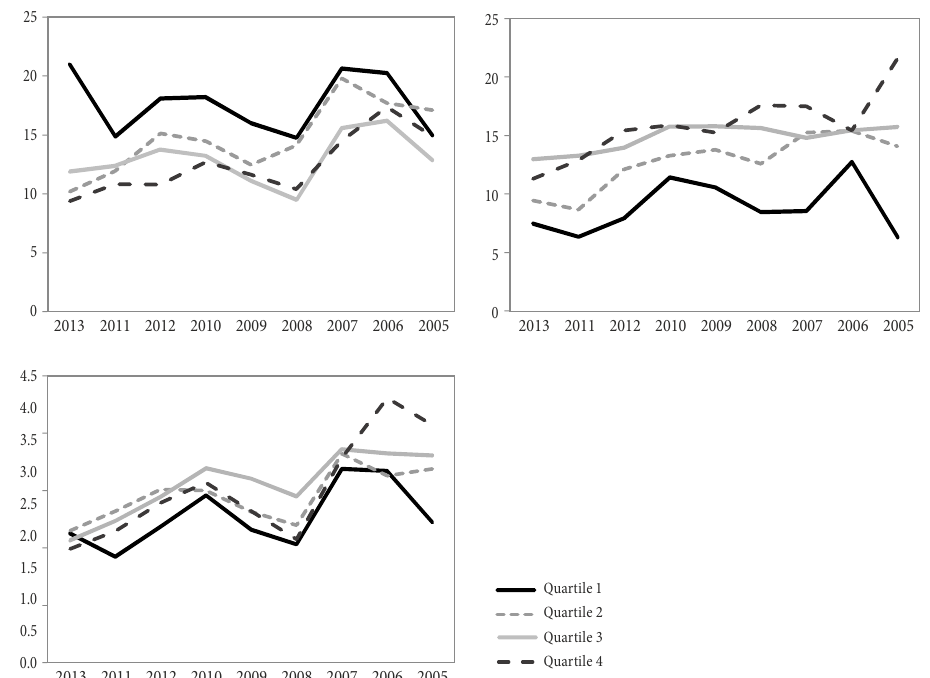
Fig. 2. Median ROE, GM and PM by Intangibles quartiles (1 st quartile – lowest level of intangibles) Source: